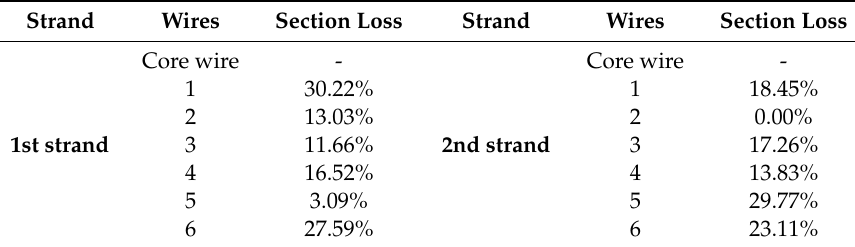
Table 4. Inspection of corroded wires in